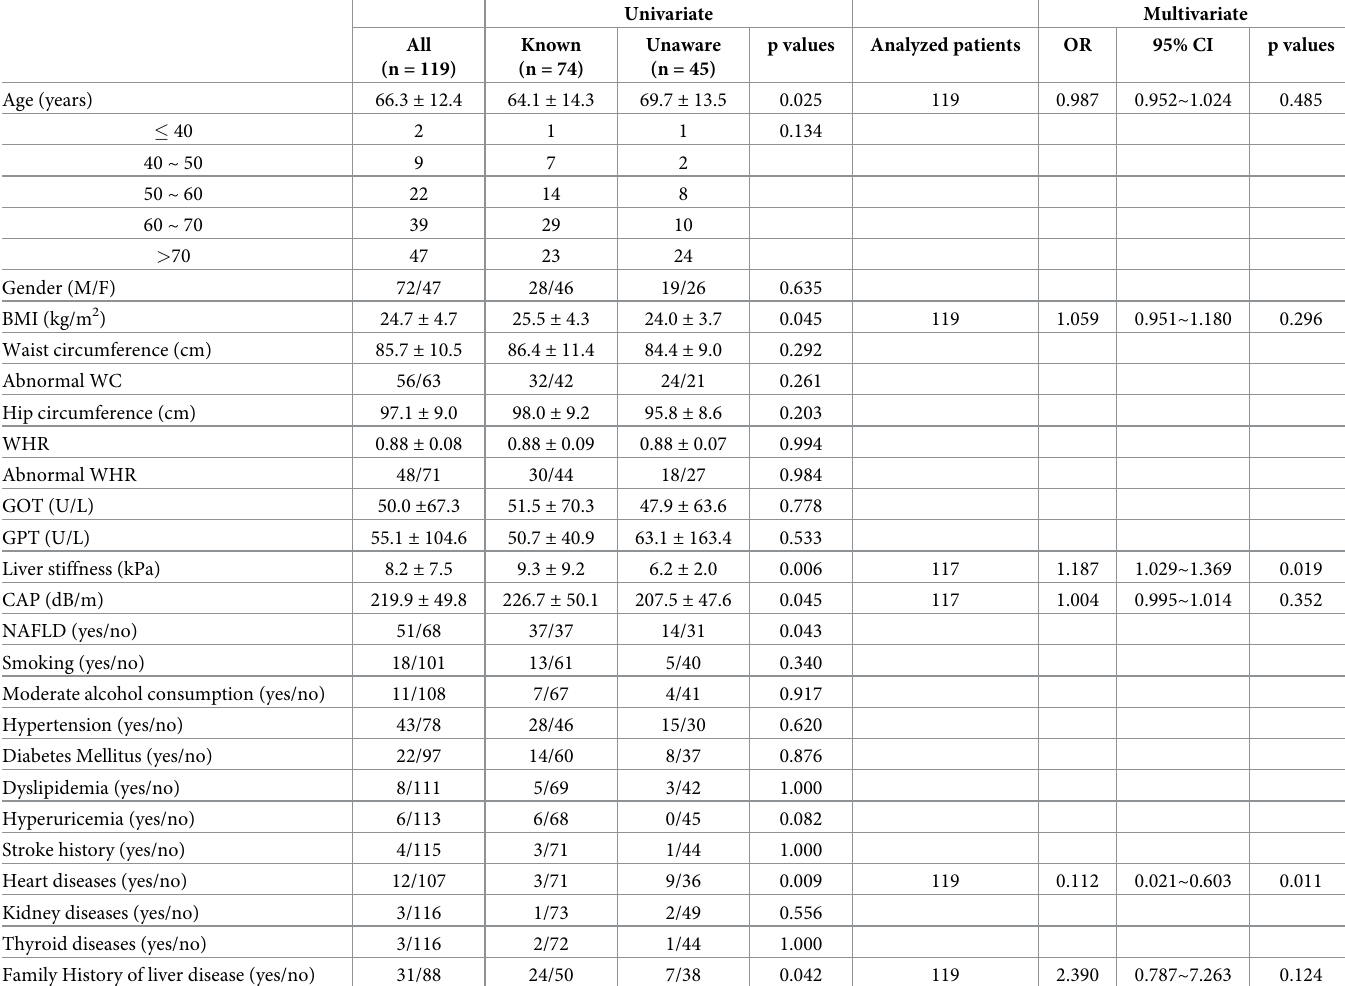
Table 3. The characteristics of HCV viremic patients with already known or unaware HCV